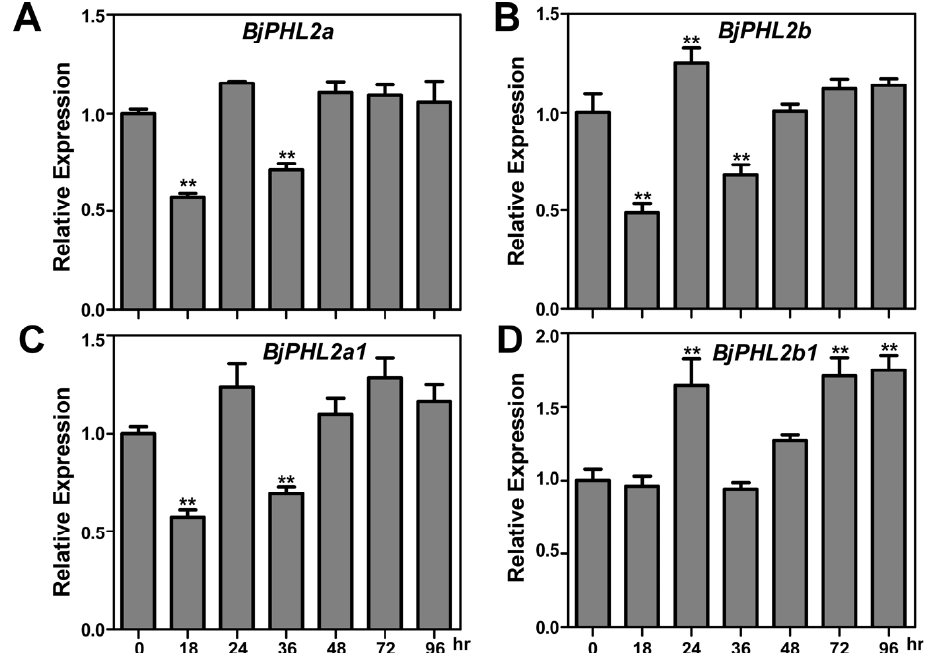
Figure 6. Expression of BjPHL2 subclade genes in response to Botrytis cinerea infection. ( A – D ) qRT- PCR analysis of the expression pattern of BjPHL2a, BjPHL2b, BjPHL2a1, and BjPHL2b1 in response to Botrytis cinerea infection. Seedlings of Brassica juncea were infected with Botrytis cinerea followed by sampling at 0, 18, 24, 36, 48, 72, and 96 hours after infection. The relative expression levels of BjPHL2a, BjPHL2b, BjPHL2a1, and BjPHL2b1 were normalized to the expression of BjuB025449 (an AtACT2-like gene in Brassica juncea